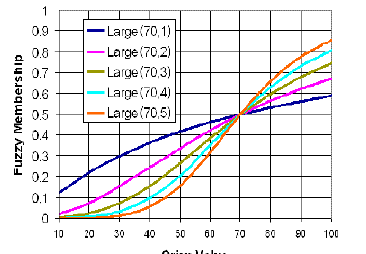
Figure 7. Variations of the Fuzzy Large membership function